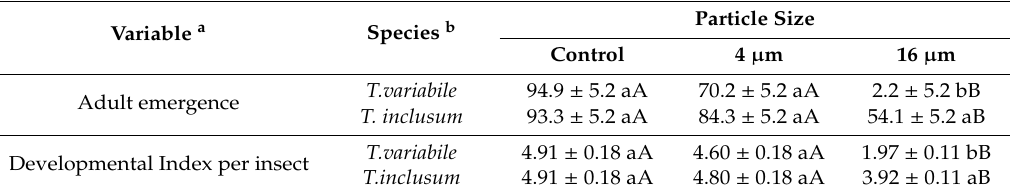
Table 4. Percent adult emergence and developmental index of dermestids in pyrethrin + methoprene aerosol treated concrete arenas after late larvae were released in arenas at week six following the application of aerosol and storage of arenas in incubators at di ff erent temperature